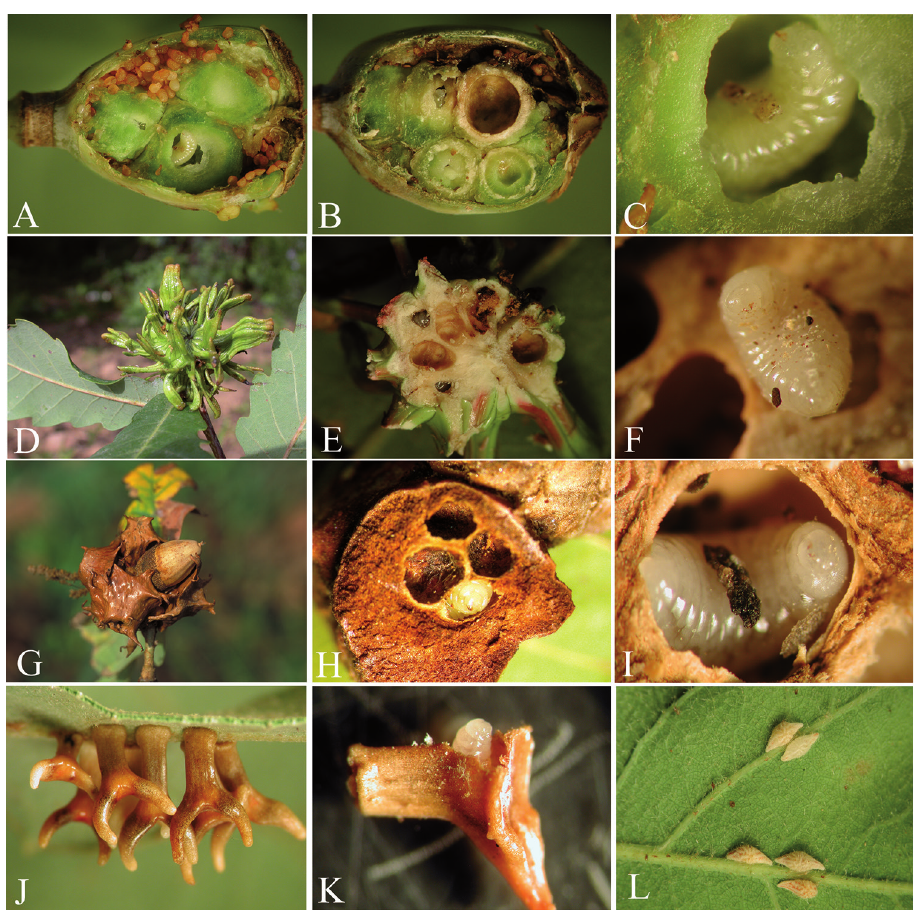
Figure 14. A cross-section of poppy head with galls of Barbotinia oraniensis B larvae of Ormyrus papav- eris within gall of B. oraniensis C larvae of Ormyrus papaveris with debris of dead host within gall cells of B. oraniensis D gall of Andricus grossulariae (asexual) on Quercus pyrenaica E cross-section of gall Andricus grossulariae (asexual) F larvae of Ormyrus pomaceus ex gall of A. grossulariae G gall of Andricus pictus on Q. pyrenaica H cross-section of gall Andricus pictus I larvae of Ormyrus pomaceus ex gall of A. pictus J galls of Trigonaspis mendesi on Q. faginea K larvae of O. pomaceus within galls of Trigonaspis mendesi on Q. faginea L galls of Trigonaspis brunneicornis on Q. faginea